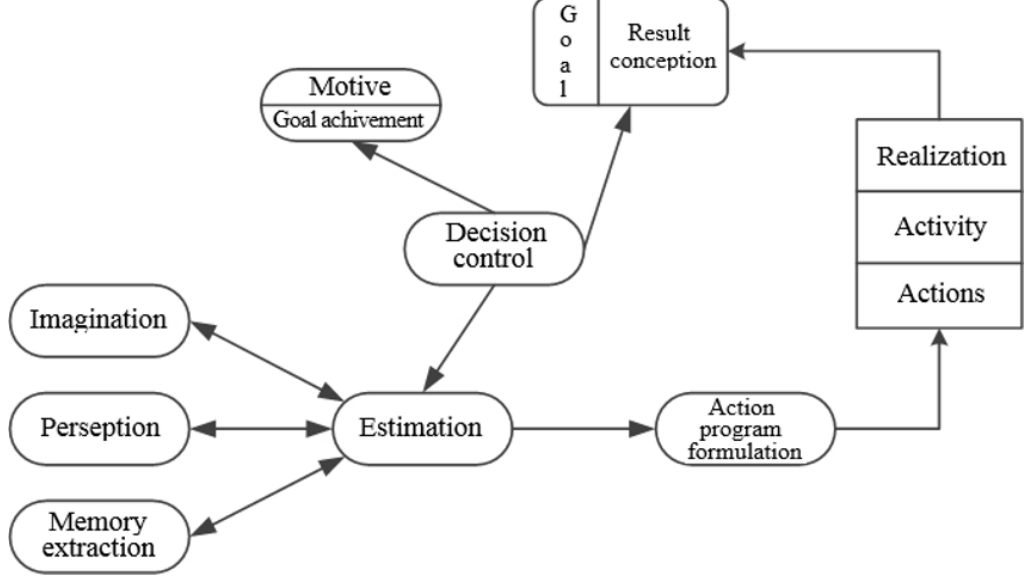
Fig. 2. The interaction of abilities in a generalized functional system of activity.